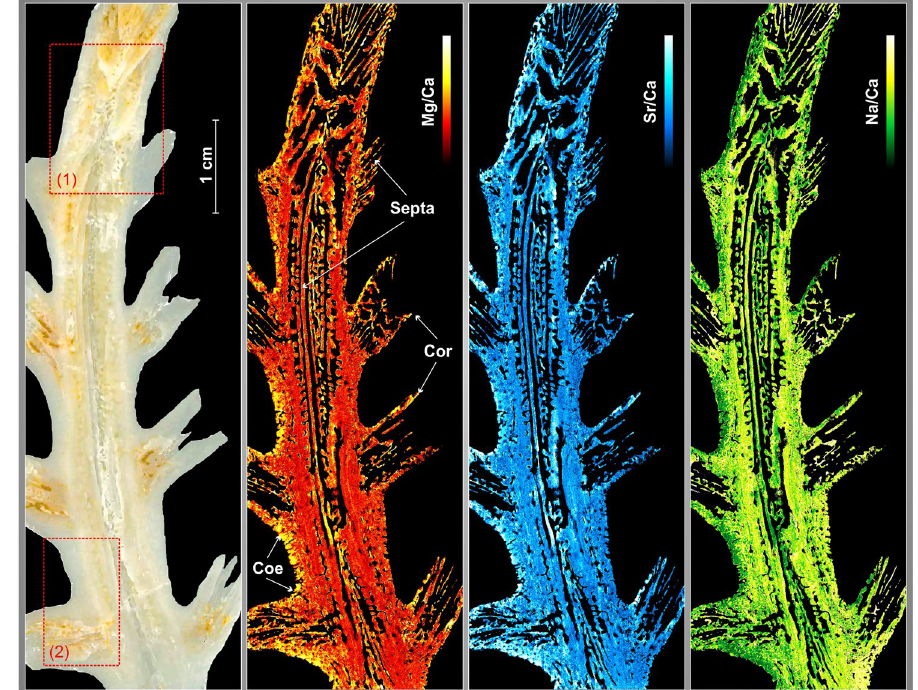
Figure 5. Optical 3300 × 1000 pixels image of Dendrophyllia ramea and its Mg/Ca, Sr/Ca and Na/Ca distributions with 25 µ m resolution. The septa, coenosteum (Coe) and corallites (Cor) are indicated in the figure by white arrows. The red dotted squares (1) and (2) indicate specific analysed regions (see below). Lighter color indicates higher